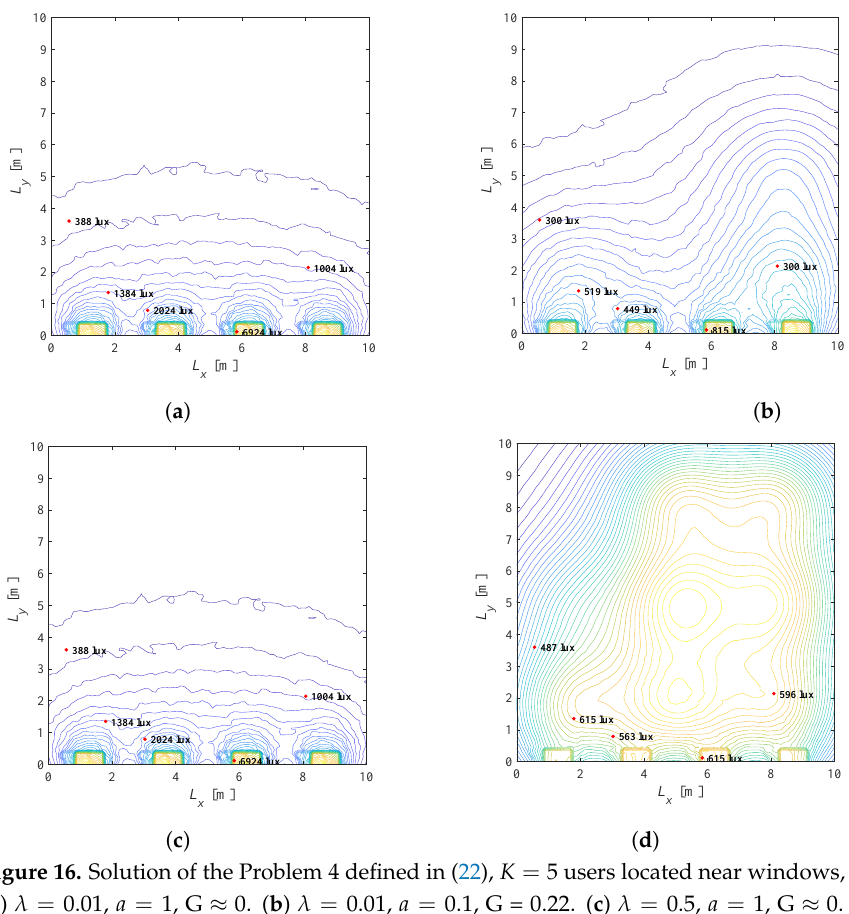
Figure 16. Solution of the Problem 4 defined in (22), K = 5 users located near windows, Φ 1/2 = 60 0 . ( a ) λ = 0.01, a = 1, G ≈ 0. ( b ) λ = 0.01, a = 0.1, G = 0.22. ( c ) λ = 0.5, a = 1, G ≈ 0. ( d ) λ = 0.5, a = 0.03, G = 0.82.